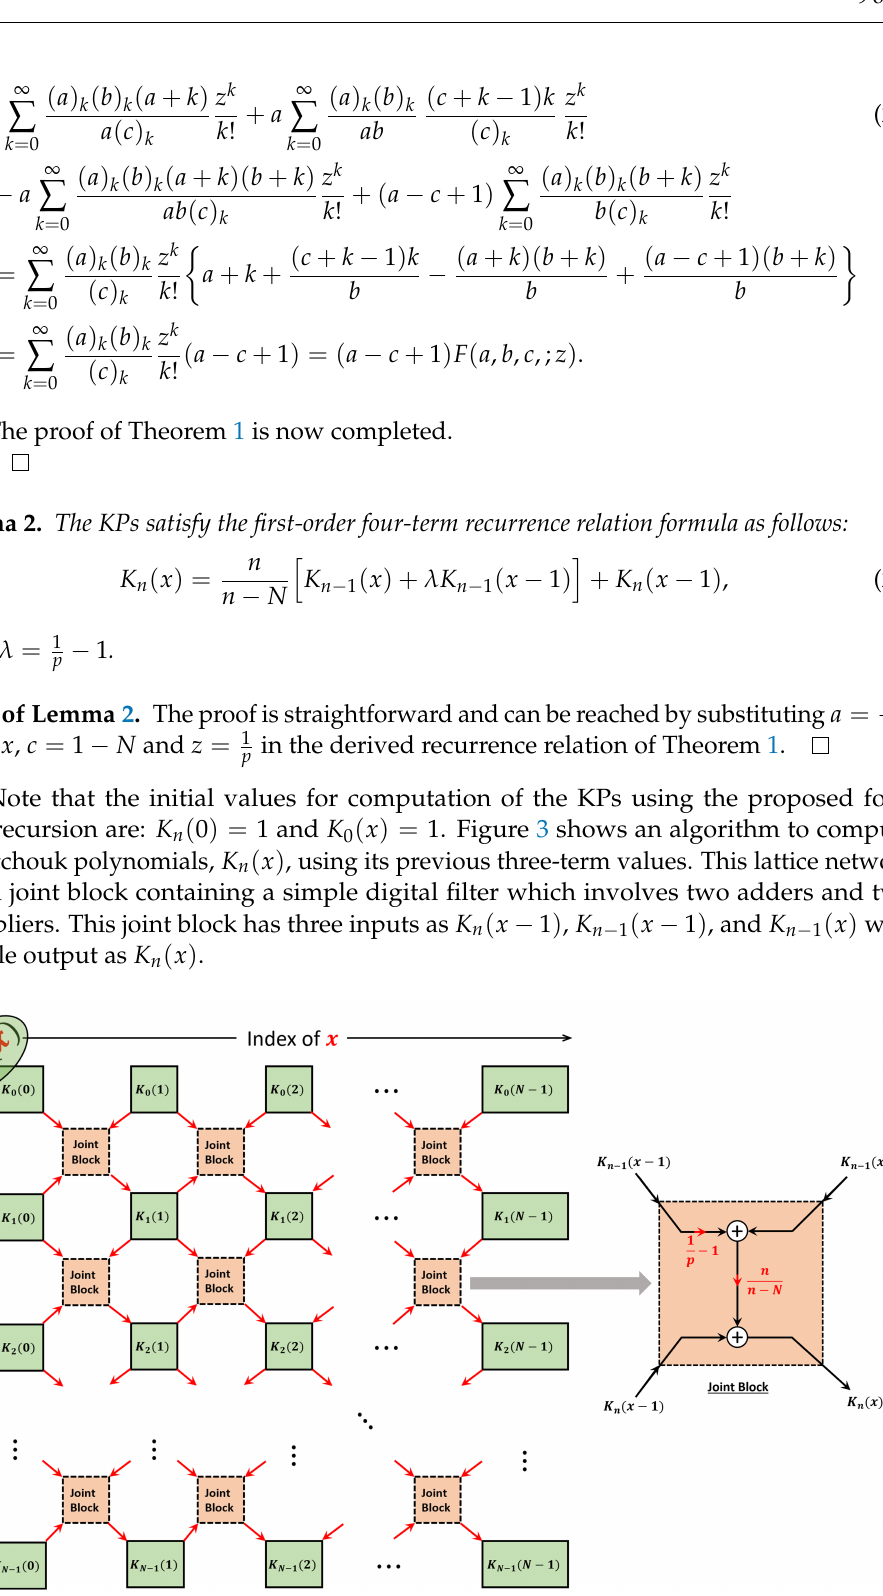
Figure 3. Lattice network for calculating Krawtchouck polynomials using the proposed four-term